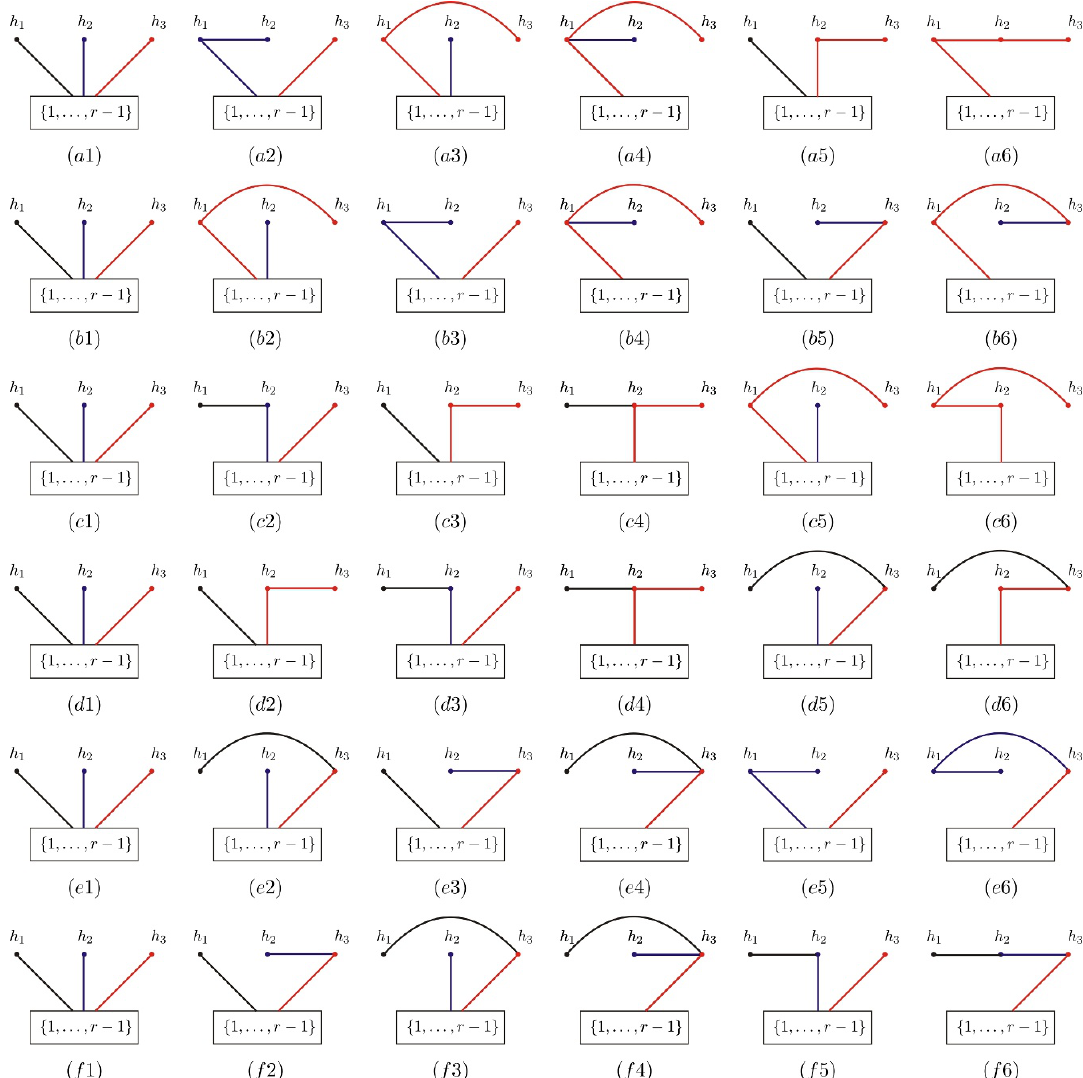
Figure 2 . All possible graphs with H = f h 1 ; h 2 ; h 3 g . Graphs in each row contribute to permutations f 2 ; : : : ; r (cid:0) 1 g (cid:27)(cid:27)(cid:27) H for a given relative order (cid:27)(cid:27)(cid:27) H